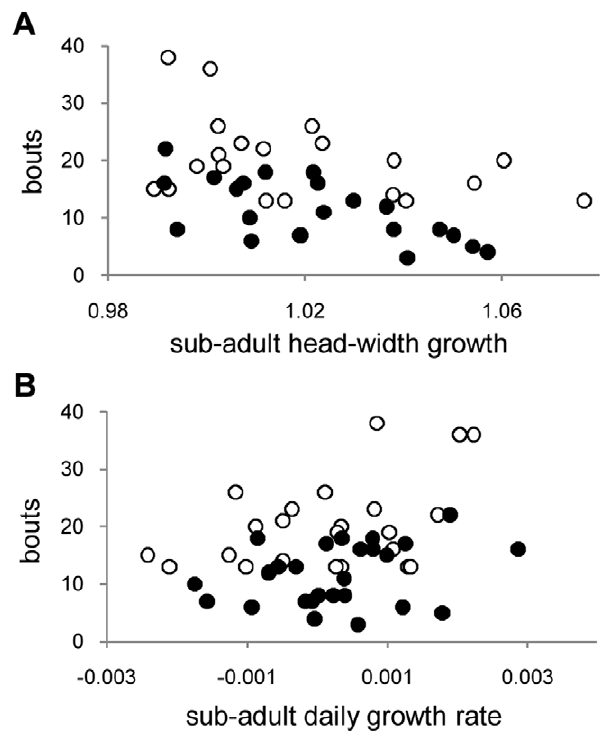
Figure 4. Relationship between early growth (day55 to day 95) and bouts required to pass the learning task. a) head width; b) mass change. (White circles – LO diet birds; black circles – HI diet birds. For statistical effects, see Table 4.)